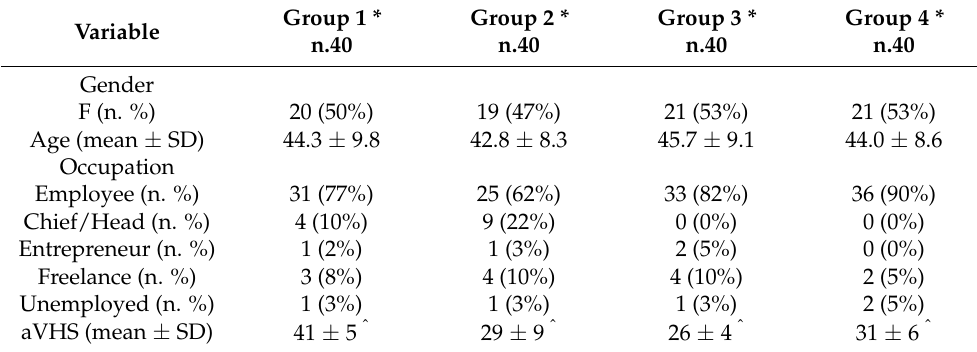
Table 1. Worker’s characteristics (n.160). Variable